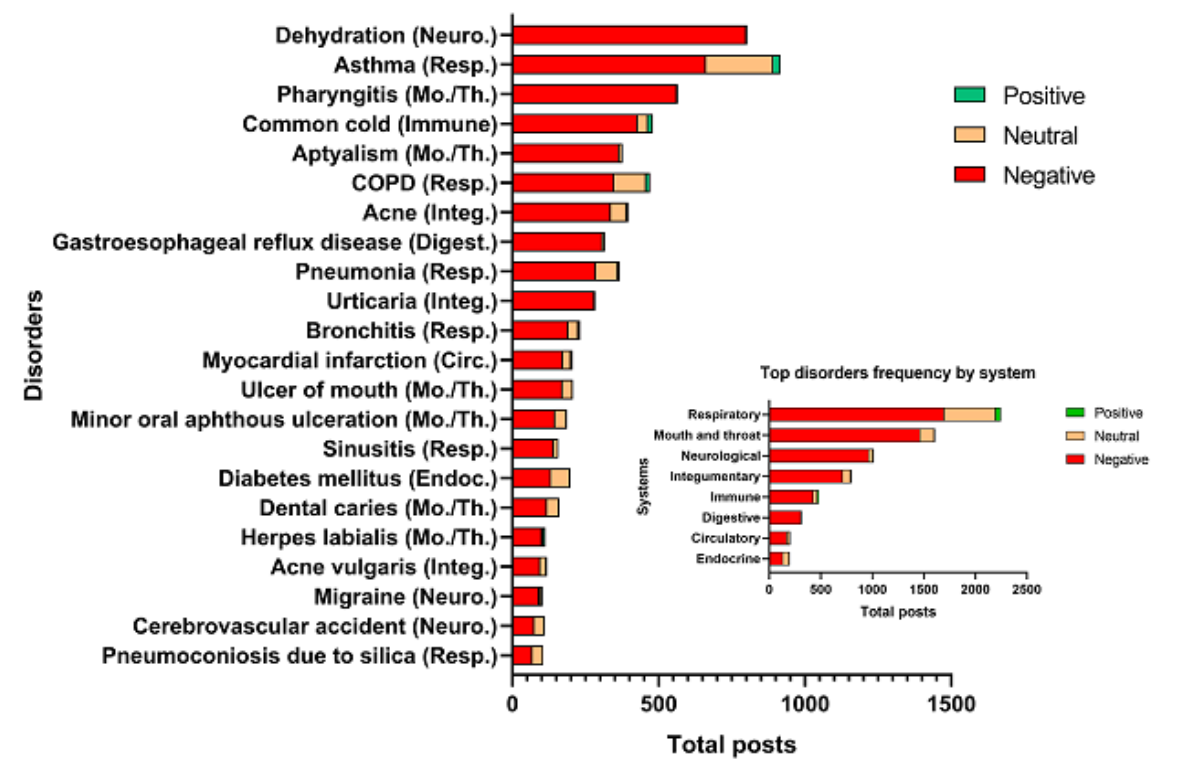
Figure 7. Frequency distribution of specific disorders with over 100 posts and frequency distribution of their systems or anatomical regions (inset). Neuro.: neurological; Resp.: respiratory; Mo./Th.: mouth and throat; Integ.: integumentary; Digest.: digestive; Circ.: circulatory; Endoc.: